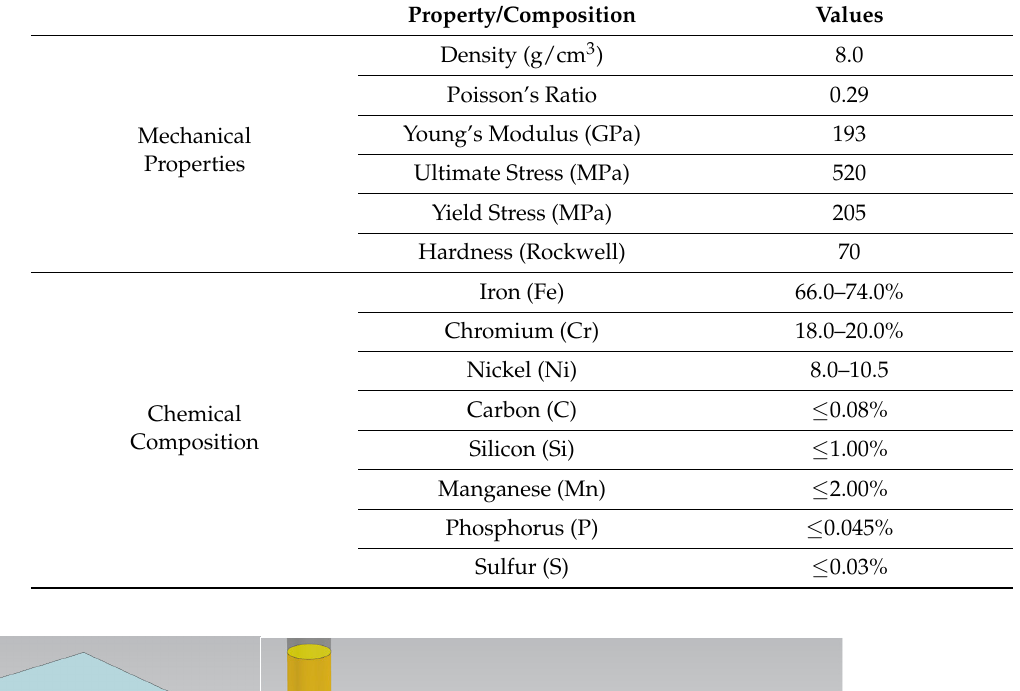
Table 1. Mechanical properties and chemical composition of SUS304.